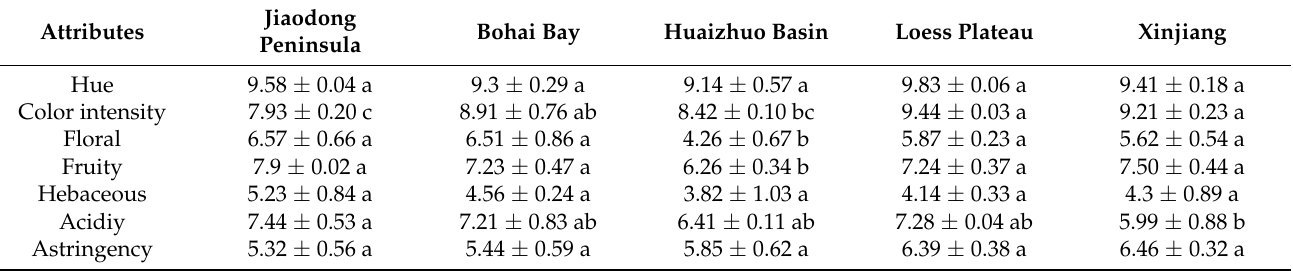
Table 5. Sensory profiles of Marselan wines from different regions of China